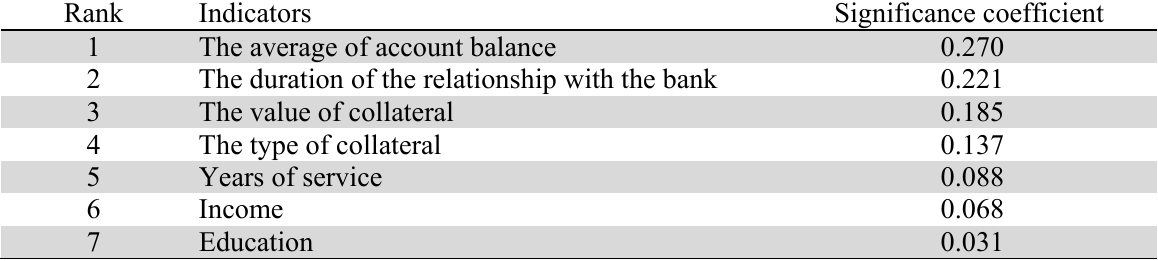
The results obtained from the analysis of the Group AHP questionnaire